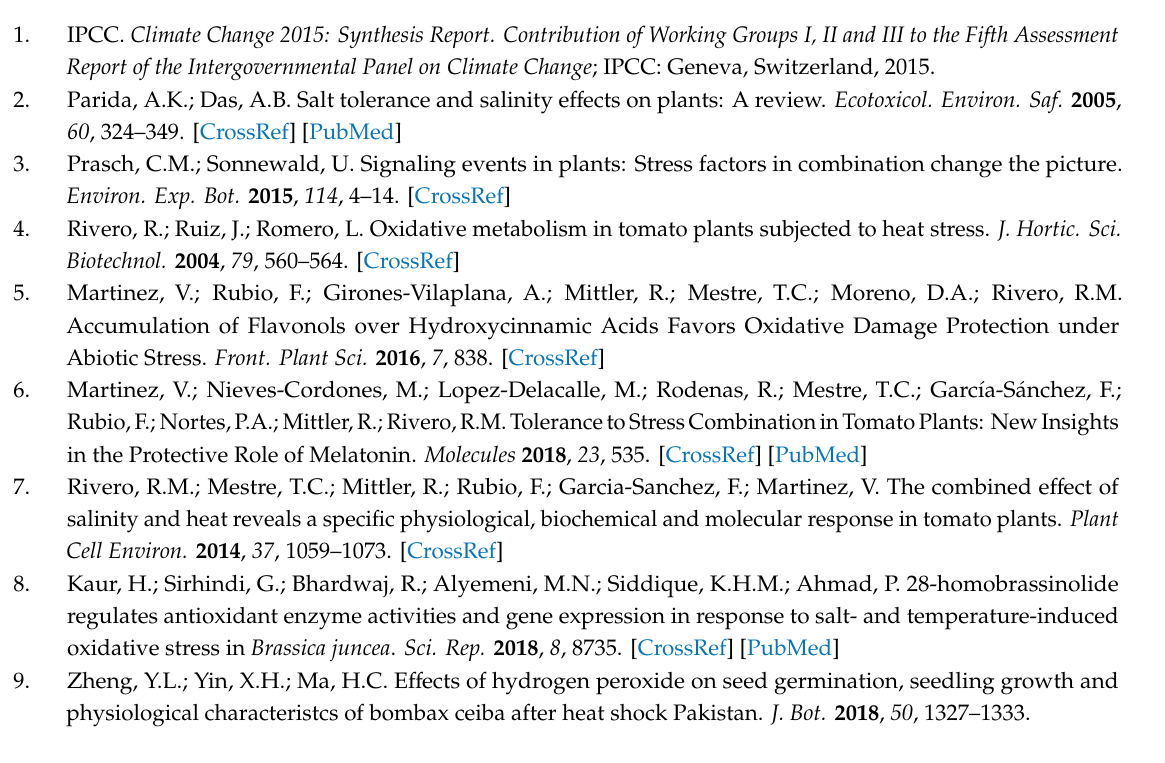
Table S1: Nutritional composition of the Hoagland solution used for tomato plants growth, Table S2: Primers used for the quantification of the expression levels of the oxidative metabolism-related transcripts by qPCR, Table S3: Relative expression values of the oxidative metabolism-related transcripts. Values were normalized against control samples and log2 was calculated and shown. Values are means of n = 3, Table S4: Absolute activities of the oxidative metabolism-related enzymes. Values obtained were normalized using soluble protein content of each sample and treatment. Values are the means ± SE ( n = 3), Table S5: Log 2 of the oxidative metabolism-related enzymes. Values obtained in Table S3 were normalized against control and log2 was calculated, Figure S1. Fresh weight (FW) of tomato plants obtained at the end of the preliminary experiment (see Materials and Methods